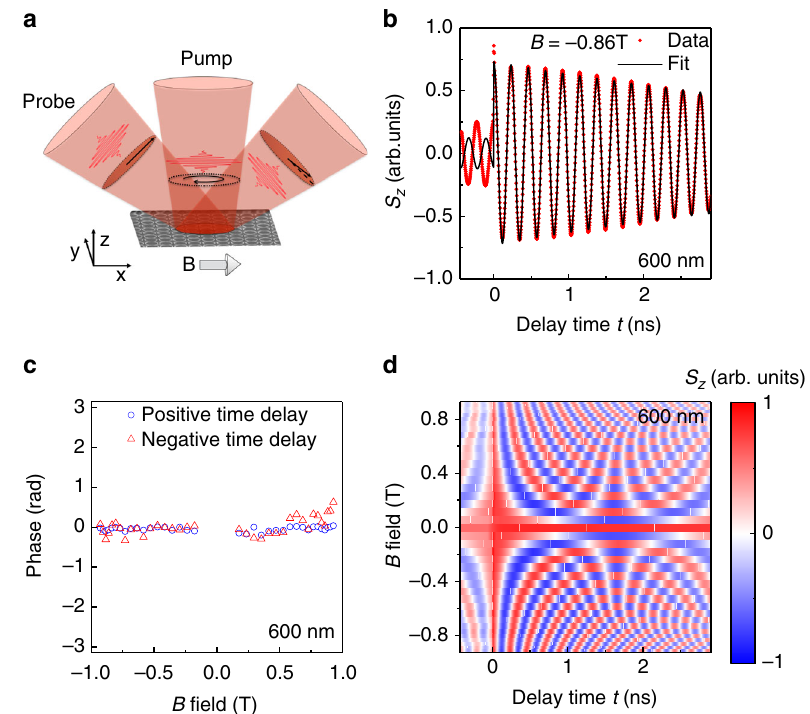
Fig. 1 Time-resolved spin dynamics in dot arrays. a Sketch of time-resolved Kerr rotation measurement of spin component S z . b Recorded S z ( t ) at a fi xed external magnetic fi eld of a 600nm dot array. c Extracted phase of the oscillation S z ( t ) at positive zero-delay ( t þ dot array. d Recorded S z ( t ) as a function of external magnetic fi eld B for 600nm dot size array. The values of S z ( t ) are color coded and normalized to